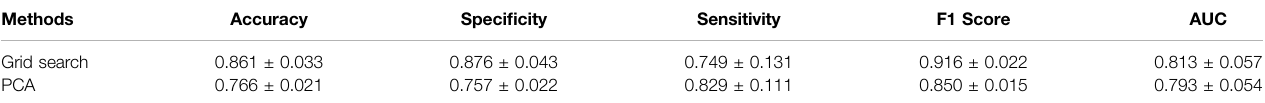
TABLE 3 | Comparison of the classi fi cation effects of two different feature selection methods for the ECG-only model Methods